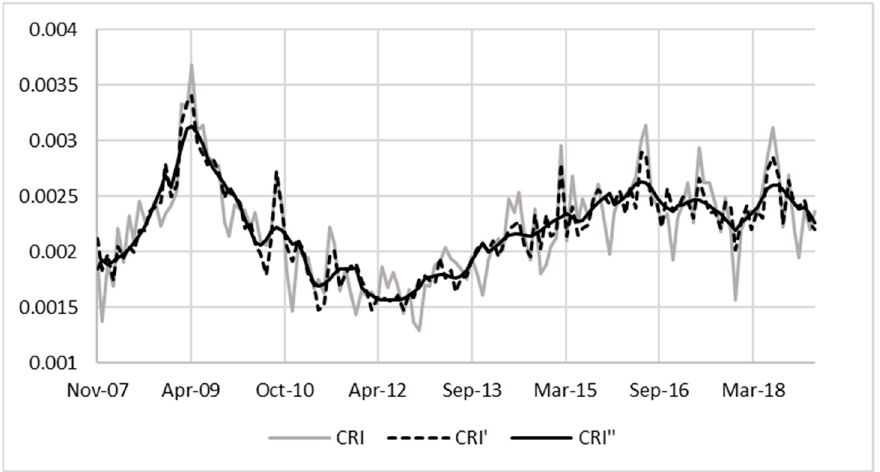
Figure 1. Constructed, seasonality adjusted and LOESS smoothed CRI.